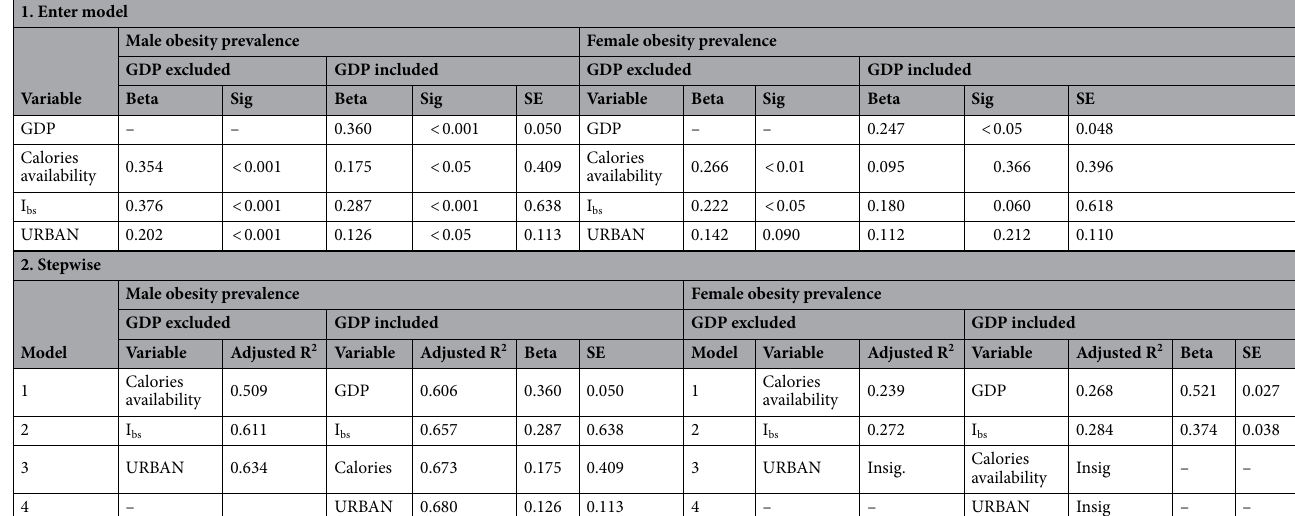
Table 3. Results of linear regression analyses to describe the relationships between obesity prevalence rates and their predictors in females and males respectively. Enter and Stepwise multiple linear regression modelling are reported. Data sources: Total calories data from the FAO’s FAOSTAT. BMI ≥ 30 prevalence (male and female) from the WHO Global Health Observatory; GDP per capita from the World Bank; Urbanization data from WHO; I bs from the previous publications. SE: standard error; Insig.: